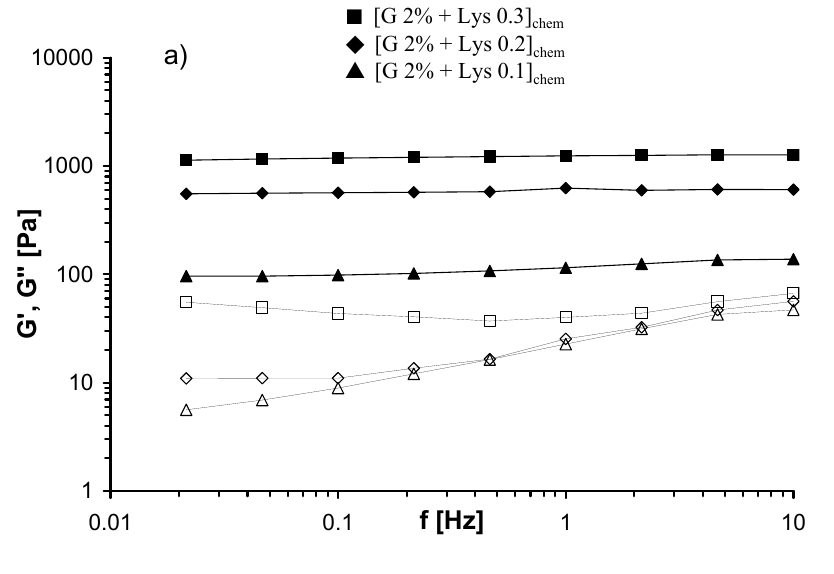
Figure 4. Frequency Sweep of Gellan chemical gels, performed at 25 °C (a) and 37 °C